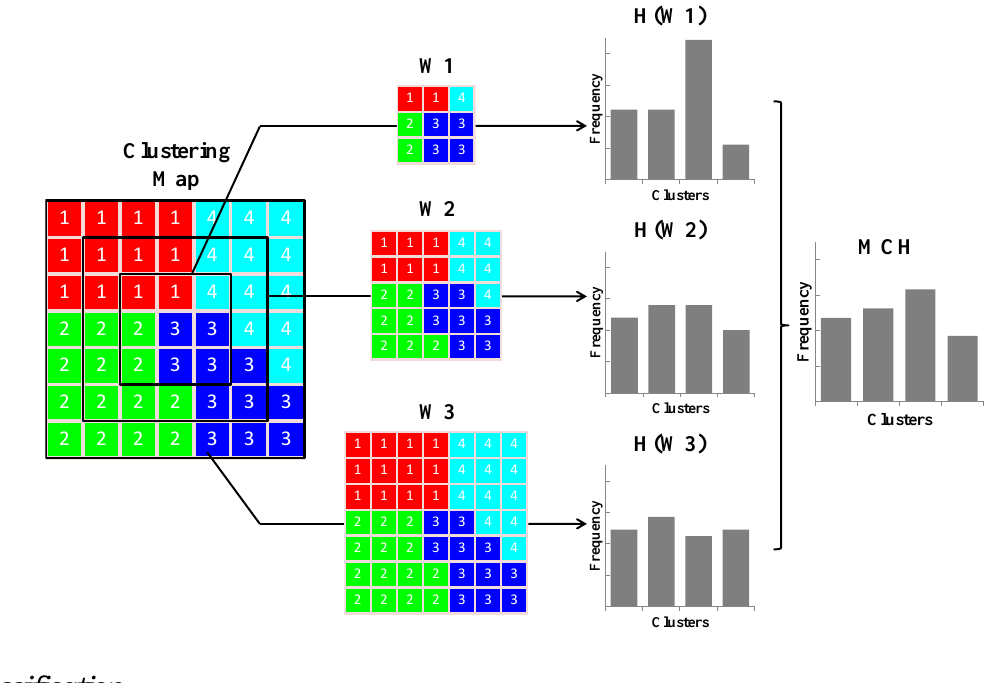
Figure 2. Demonstration of the MCH (W is the local window, and H is the corresponding cluster